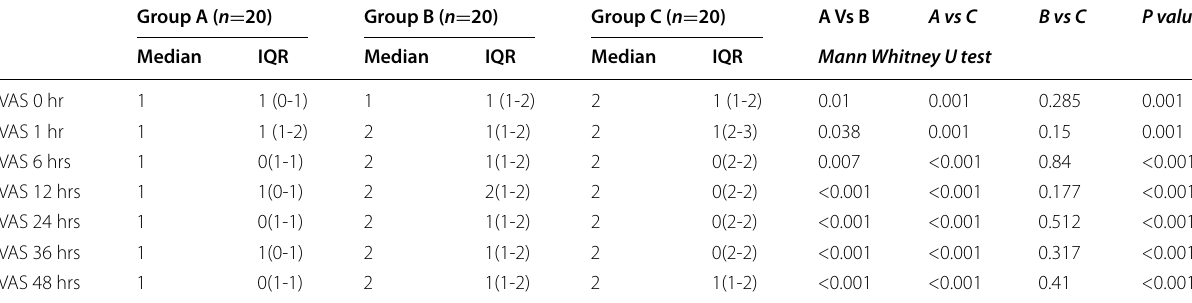
Table 2 Comparison between the three groups as regard the VAS score